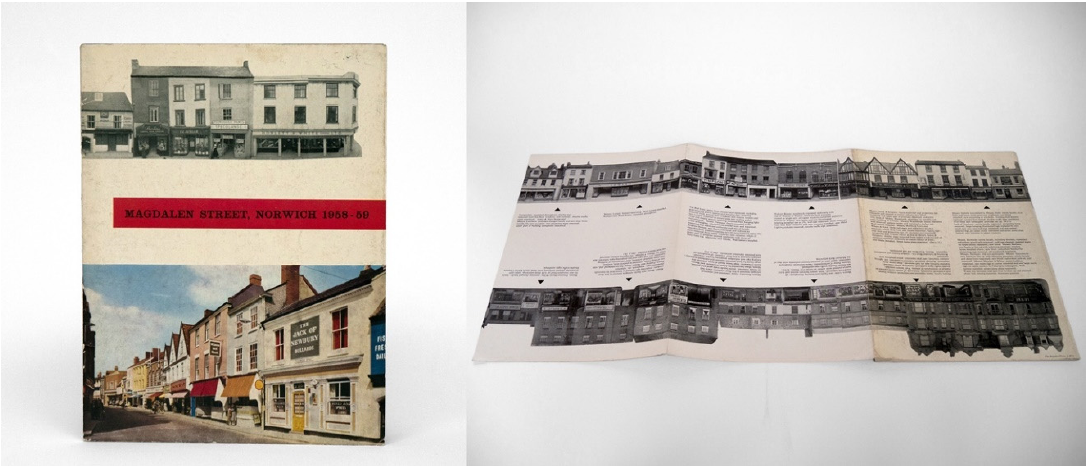
Figure 8. Civic Trust, Magdalen Street, Norwich: An Experiment in Civic Design 1958–59, 1959. Photography Philip Armes.